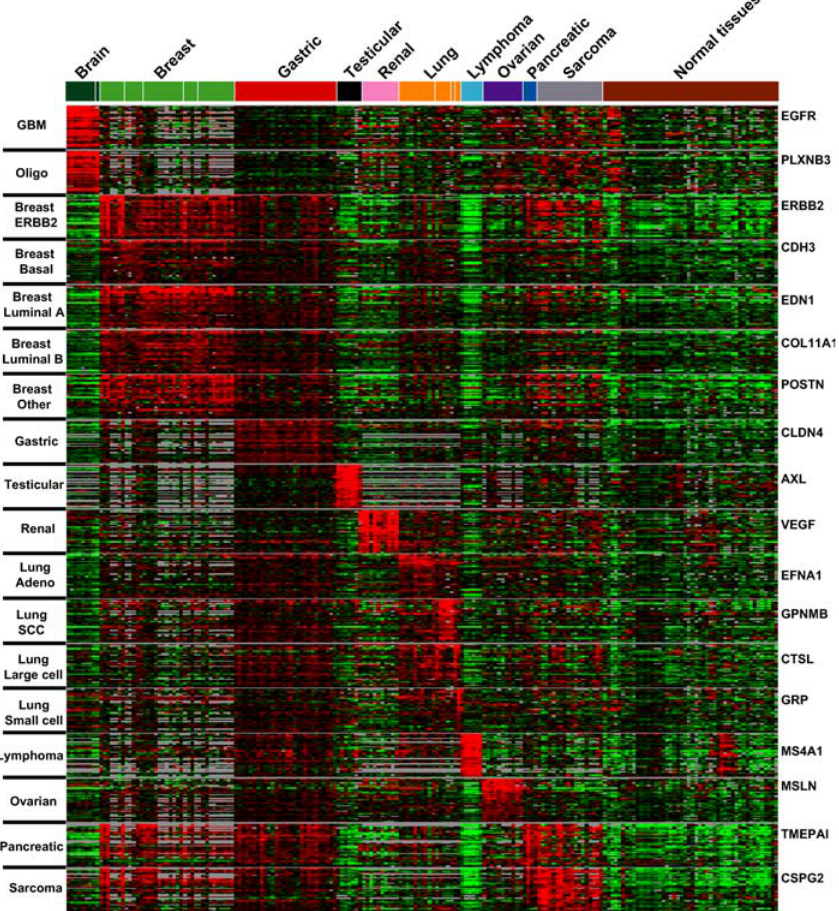
Figure 5. Identification of MS Tumor